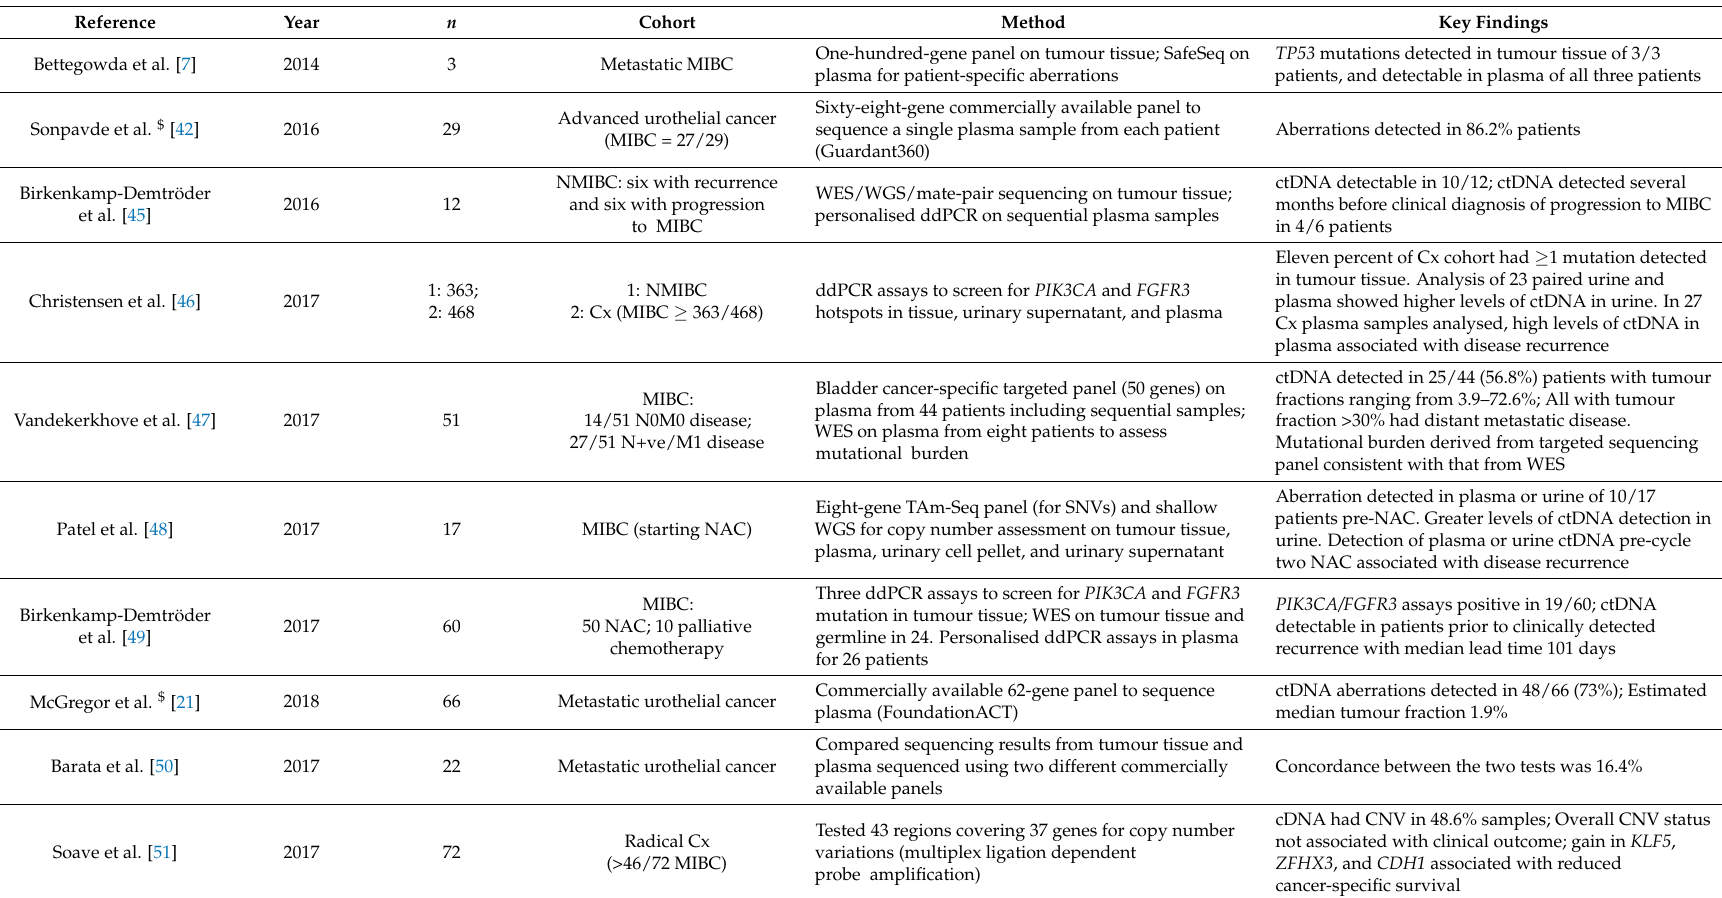
Table 1. Representative publications including select poster abstracts as of June